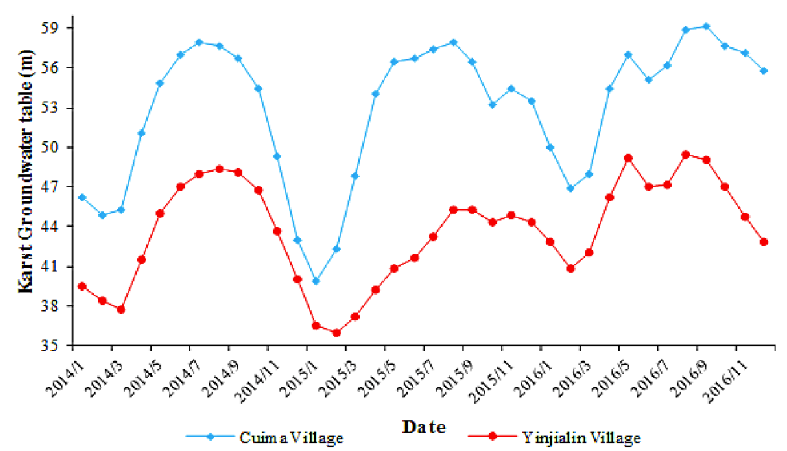
Figure 6. Conditions of karst groundwater table in Cuima and Yinjialin Villages from 2014 to 2016.